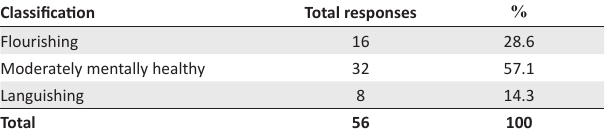
TABLE 6: Prevalence of flourishing amongst participants who dropped out of the study ( N = 56). Classification